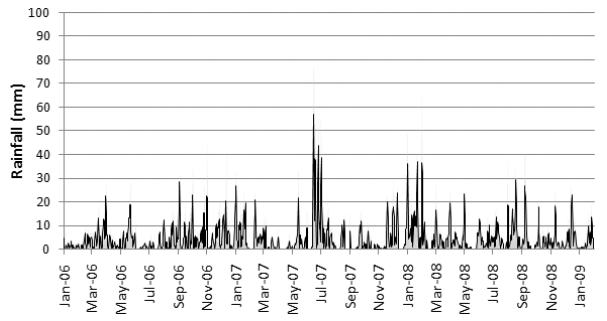
Figure 5. Sensor network maintenance vs.